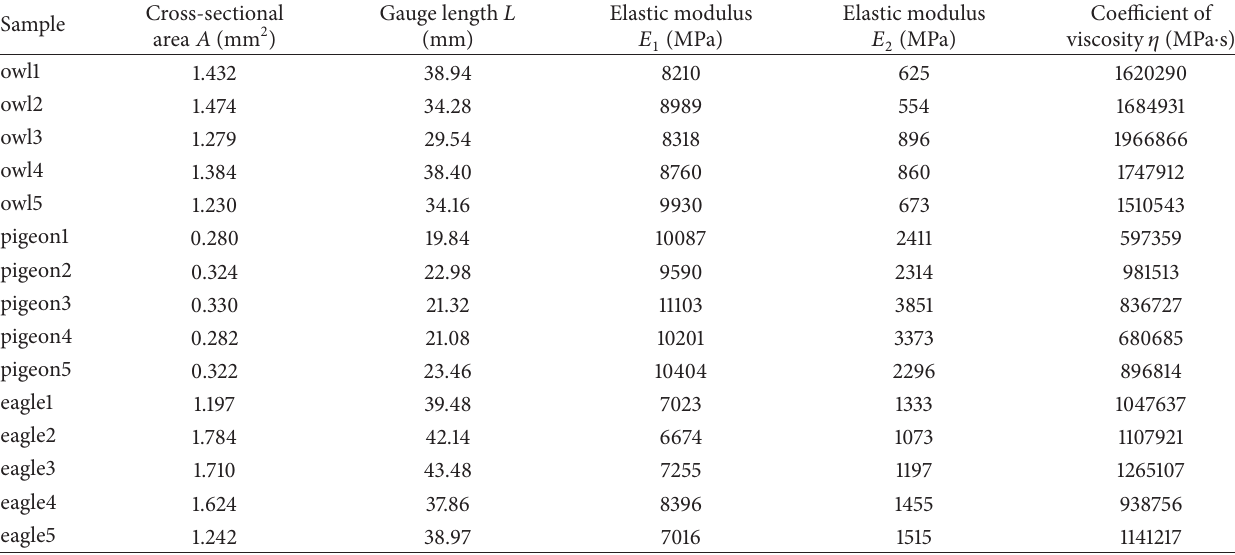
Table 1: Fitting parameters based on the viscoelastic model from tensile tests for the long-eared owl, pigeon, and golden eagle flight feather shafts.